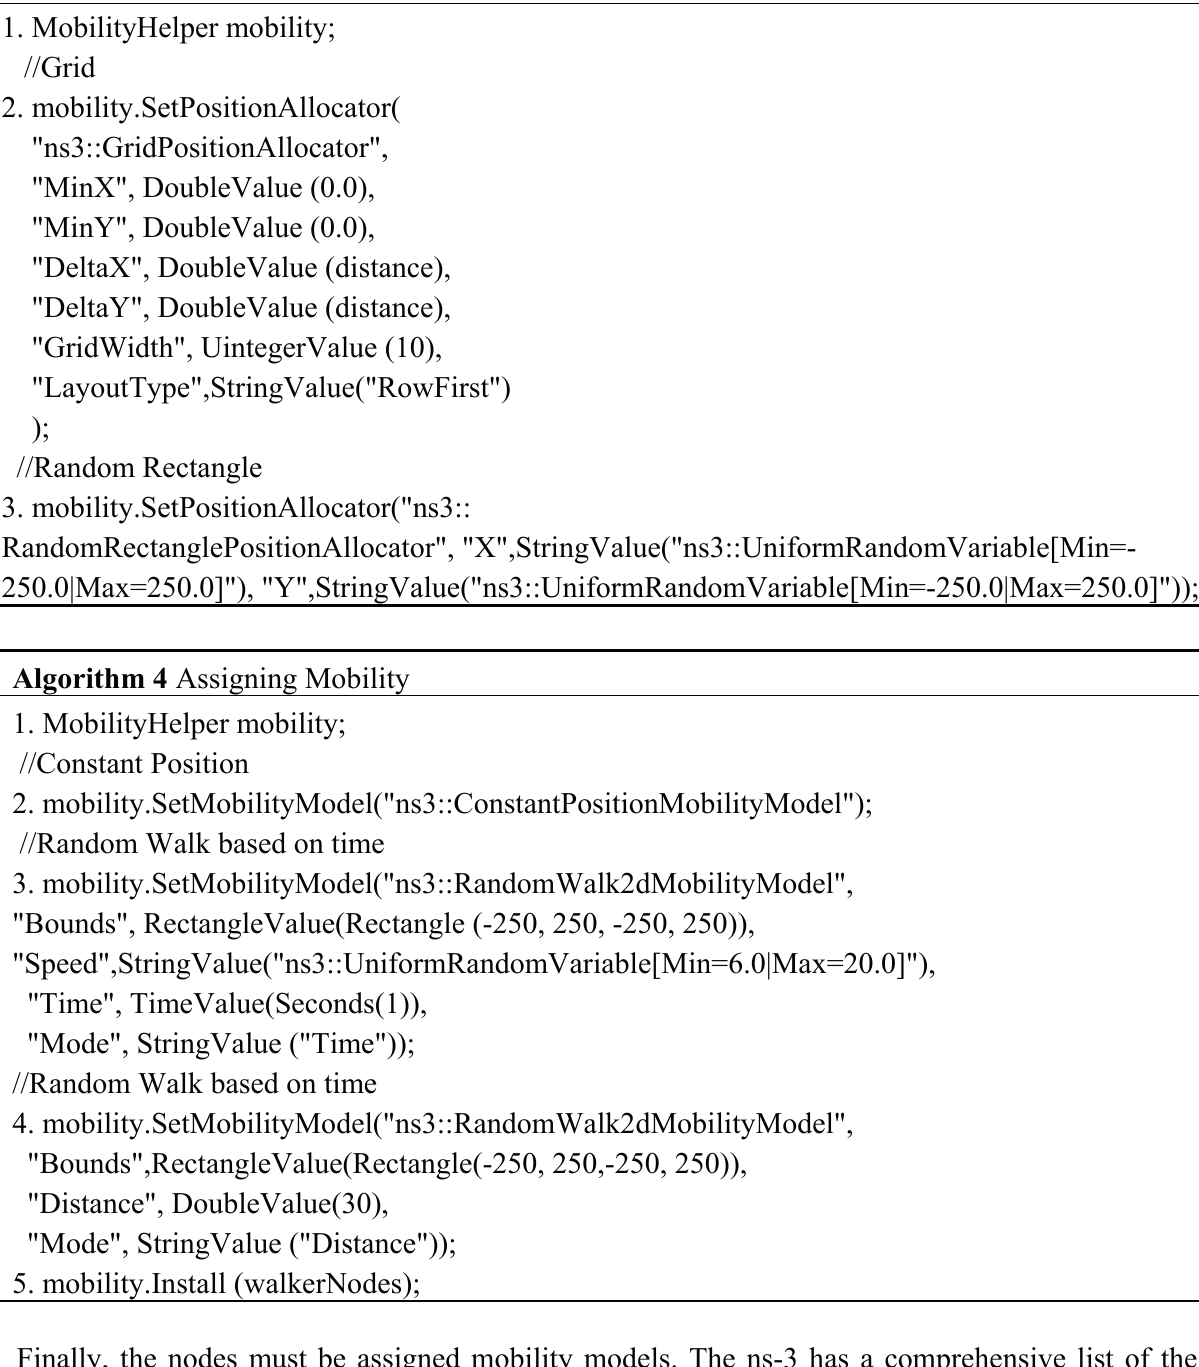
Algorithm 3. Position